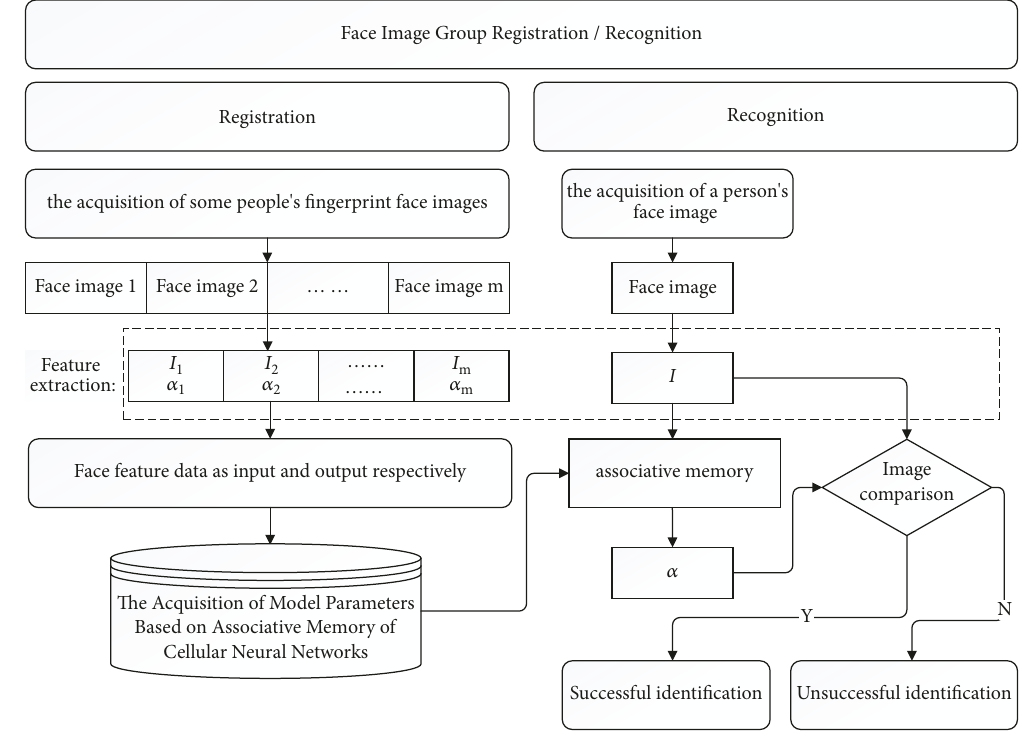
Figure 2: Process of the face recognition method by AM based on